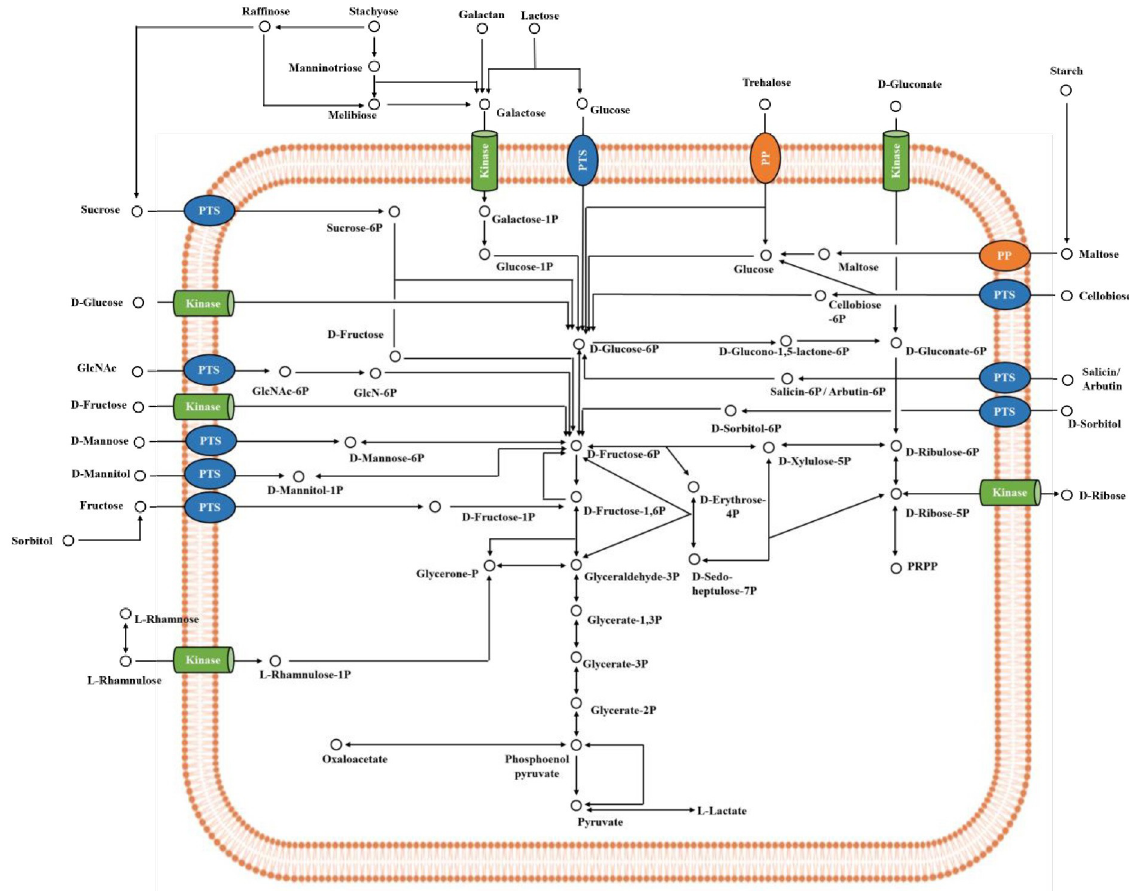
Fig 5. In silico carbohydrate utilization pathways of Lactiplantibacillus plantarum PMO 08 constructed by whole genome sequences. PTS, phosphotransferase; PP, phosphorylase.